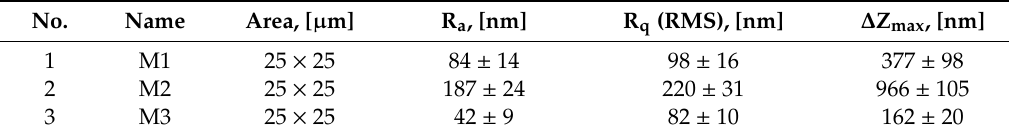
Table 6. Results of AFM surface roughness